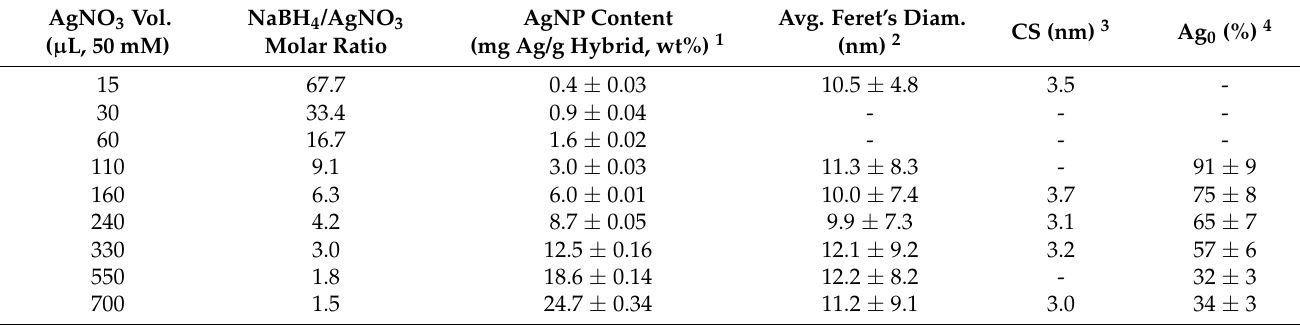
Table 1. Characteristics of cellulose nanocrystal (CNC)/AgNP hybrids at different AgNP contents. AgNO 3 Vol.